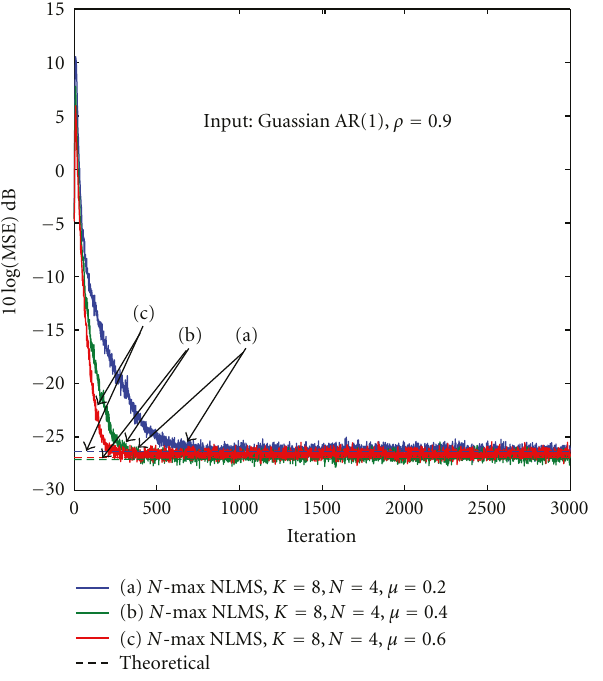
Figure 12: Learning curves of N -Max NLMS with M = 8 and N = 4 and di ff erent values of the step size for colored Gaussian input signal.